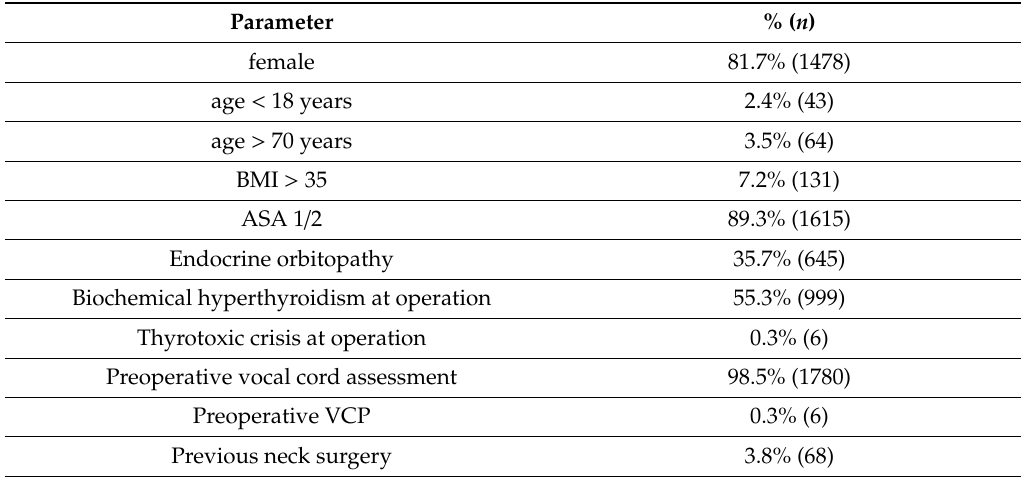
Table 2. Preoperative data of 1808 patients with GD (Graves’ disease) who underwent thyroid resection.